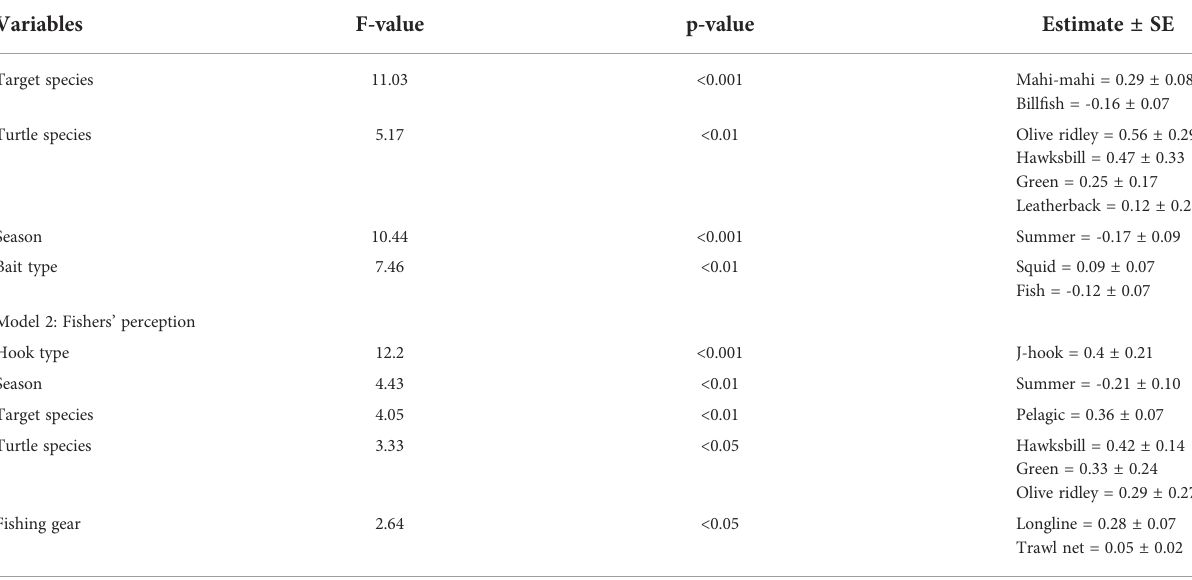
TABLE 2 F, p -values and coef fi cients of the variables included in the mixed linear model to explain the by-catch of sea turtles according to the observers ’ data (Model 1) and fi shers ’ perception (Model 2). Model 1: Observed